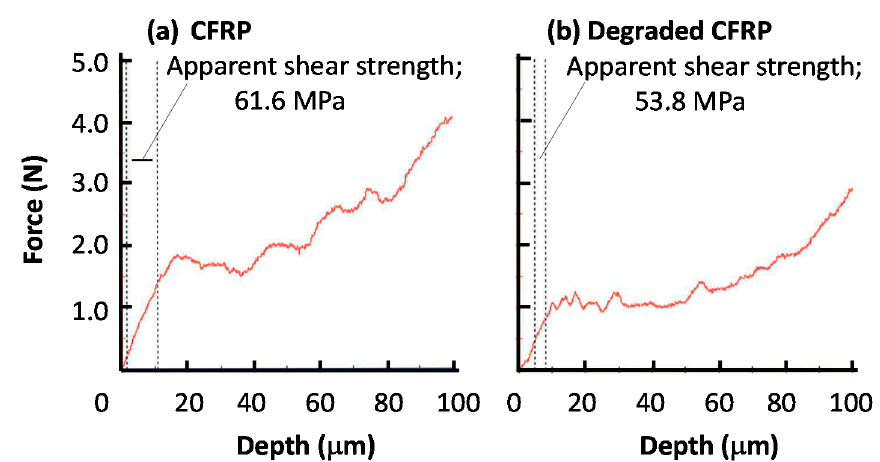
Figure 15. Force during slant cutting by using the surface and interfacial cutting analysis system (SAICAS) for the original CFRP ( a ) and degraded CFRP ( b ) samples.